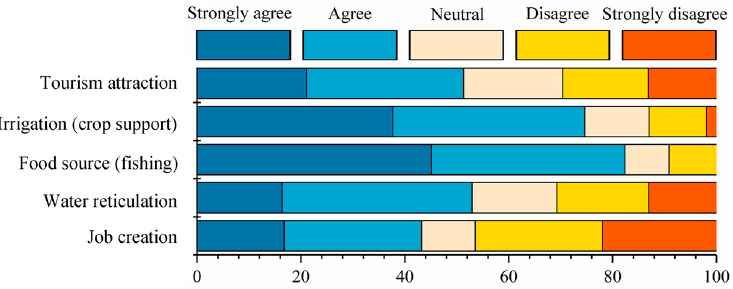
Figure 15. Perceptions of ecosystem services in the Nzhelele and Levuvhu river catchments.